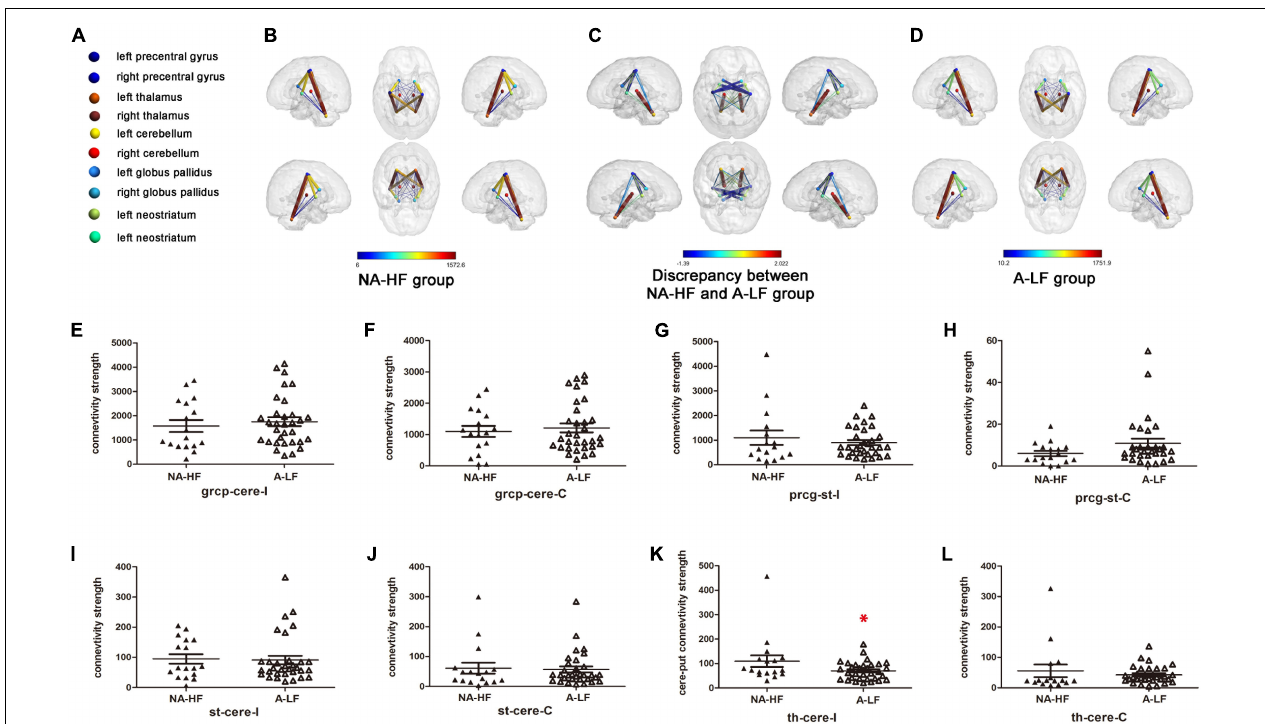
FIGURE 2 | Comparisons of clusters with significant connectivity between motor regions in the A-LF and NA-HF groups with multiple corrections by diffusion tensor imaging (DTI) at 3 months old. (A) Color-coded spheres present motor-related ROIs. (B–D) Locations and signs of brain structural connectivity between motor-related regions are illustrated. Spheres represent regions of interest (ROIs). Neostriatum and globus pallidus stand for striatum. Sticks with colors from blue to red represent probabilistic brain structural connectivity for an ROI pair. Color bars in (B,D) indicate the connectivity enrichment. Color bars in (C) indicate the discrepancy between the A-LF group and NA-HF group, respectively. (E–L) Comparisons of structural connectivity showed lower enrichment between cerebellum and ipsilateral thalamus in the A-LF group compared with the NA-HF group, and no significant difference was detected between other ROIs. grcp, precentralgyrus; cere, cerebellum; th, thalamus; st, striatum (include caudate nucleus, Cau/globus pallidus, GP); I, ipsilateral; C, contralateral; * p <